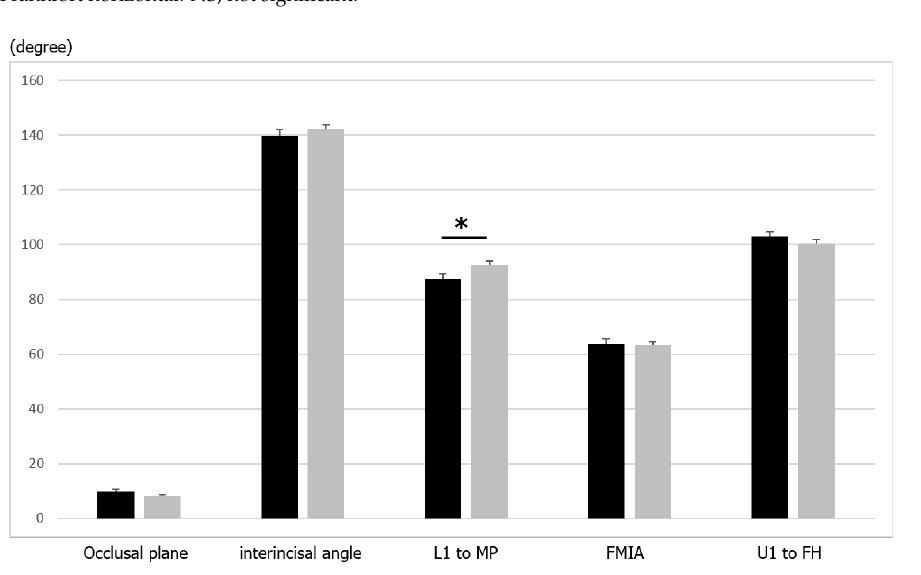
Table 3. Comparison of dentoalveolar variables between samurai and commoners. Variables (Degrees)